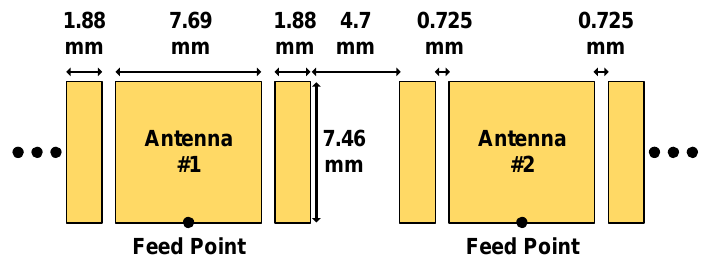
Figure 16. Dimensions for the patch